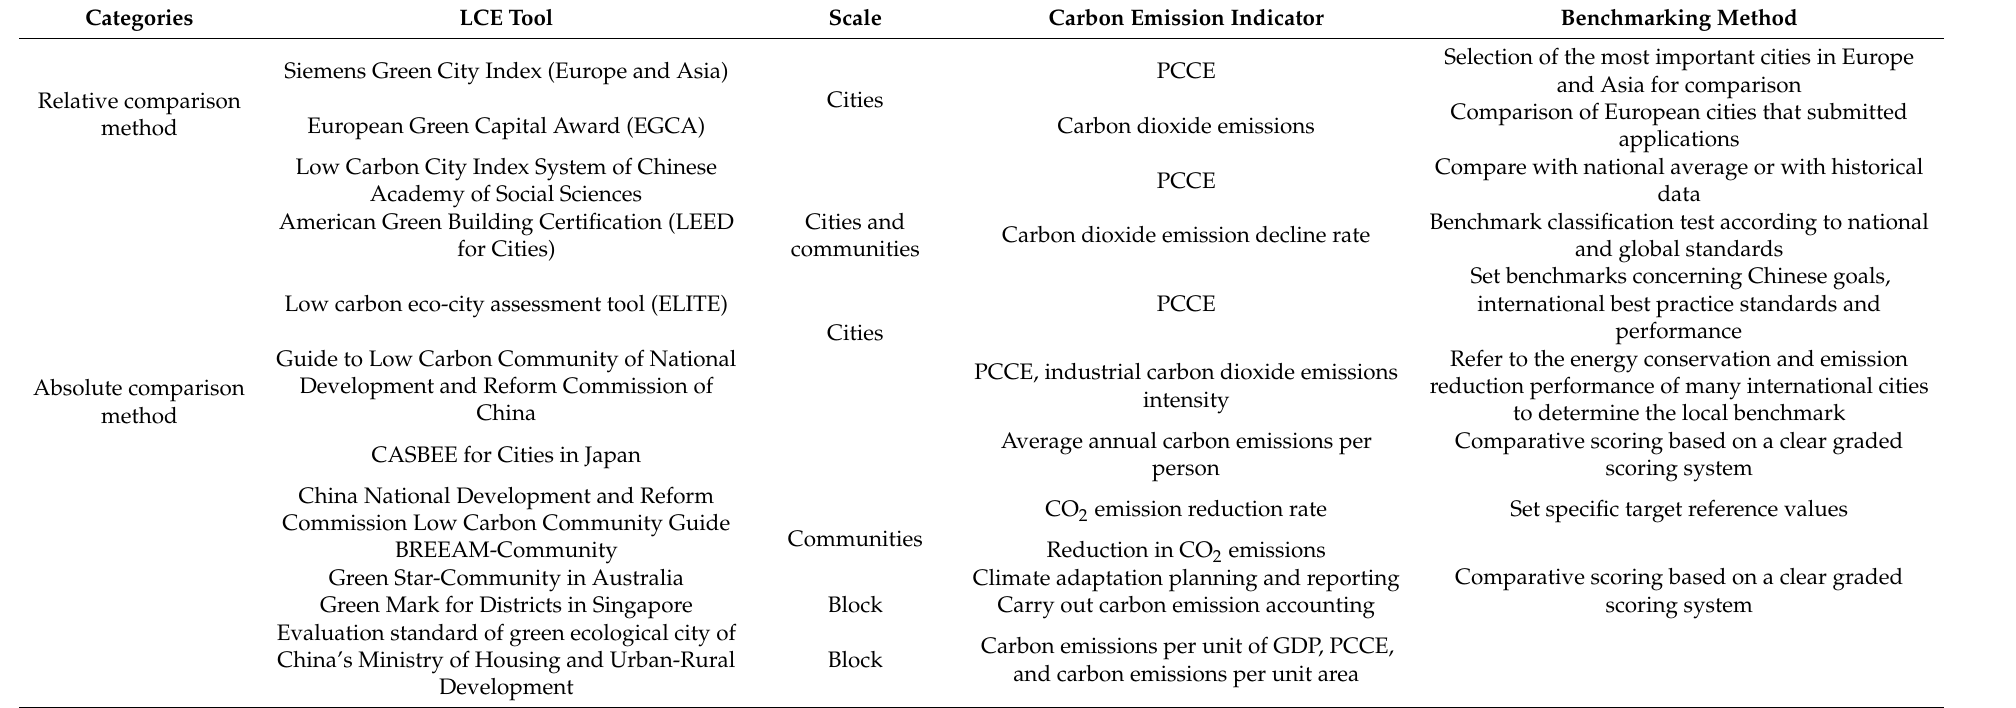
Table 1. Per capita carbon emission (PCCE)-related low-carbon evaluation (LCE) tools and benchmarking